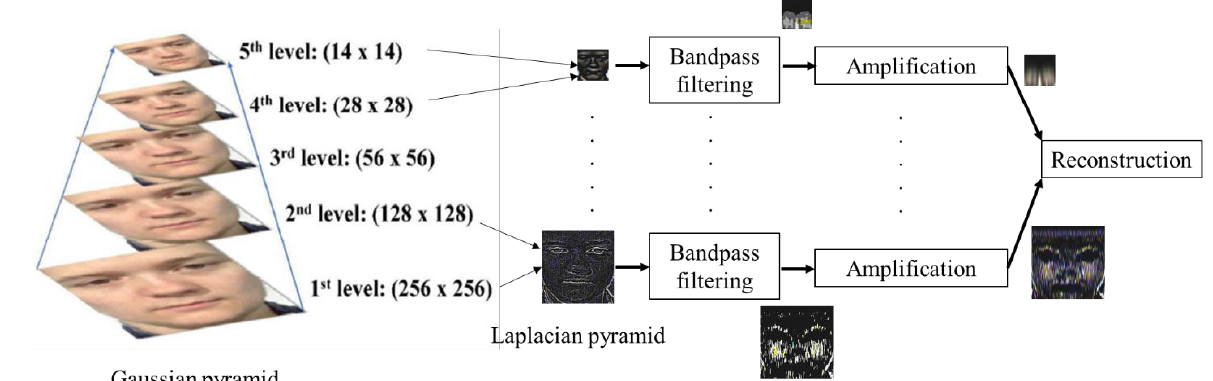
Figure 7. The flow of pre-processing of the ME video by EVM.